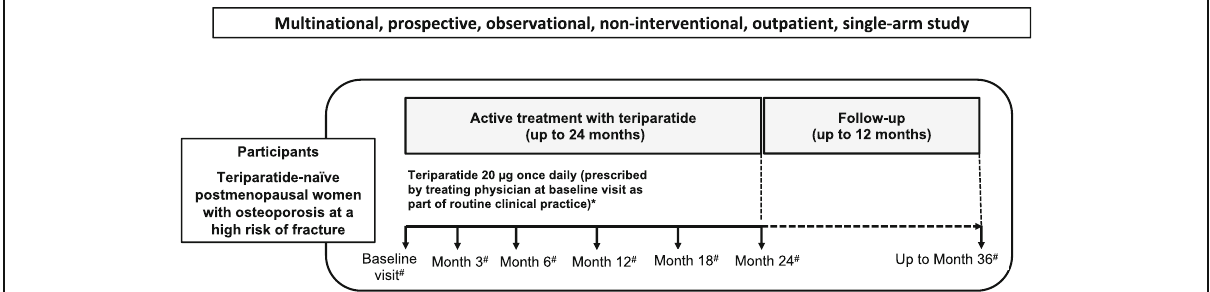
Fig. 1 ALAFOS study design. *The treating physicians were responsible for all decisions regarding diagnosis and treatment according to